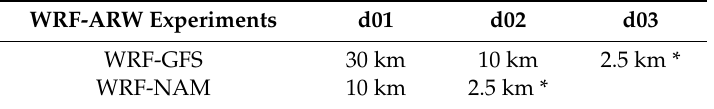
Table 4. Horizontal resolution of the nested domains in our WRF-ARW experiments with di ff erent initial conditions and lateral boundary conditions. In the 2.5 km convective-permitting domain, we